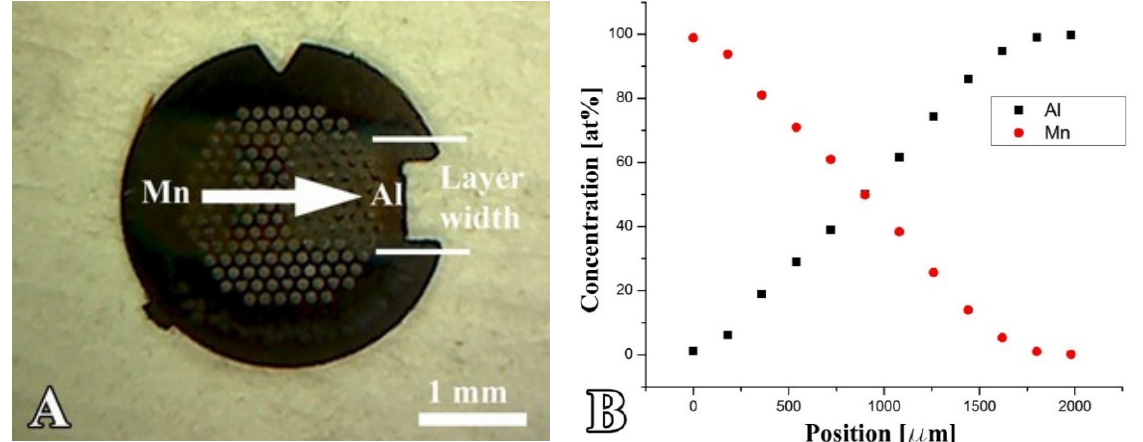
Figure 4. ( A ) Thin Mn–Al micro-combinatorial sample deposited on a Mo TEM grid via dual DC magnetron sputtering. The 1 mm wide layer strip consists of a 1.5 mm long gradient Mn–Al section enclosed by 0.25 mm long pure Mn and pure Al sections. ( B ) Mn and Al concentration profiles measured by EDS as a function of the position along the TEM grid shown in “A”.